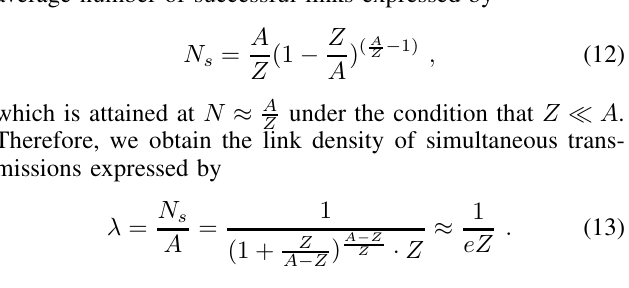
Fig. 1. Parameters in basic communication link. d denotes the distance between sender S and receiver R . d cs , d rz and d in denote the carrier sensing range, size of carrier sensing reservation zone and interference range respectively.